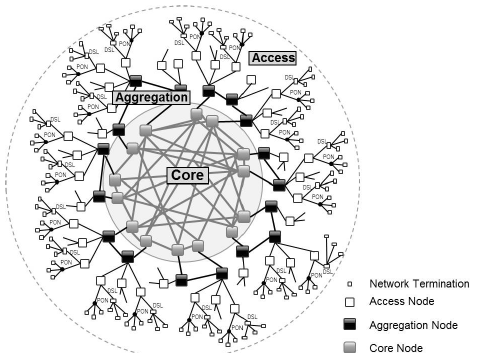
Figure 1: Intra-domain network topology (source: